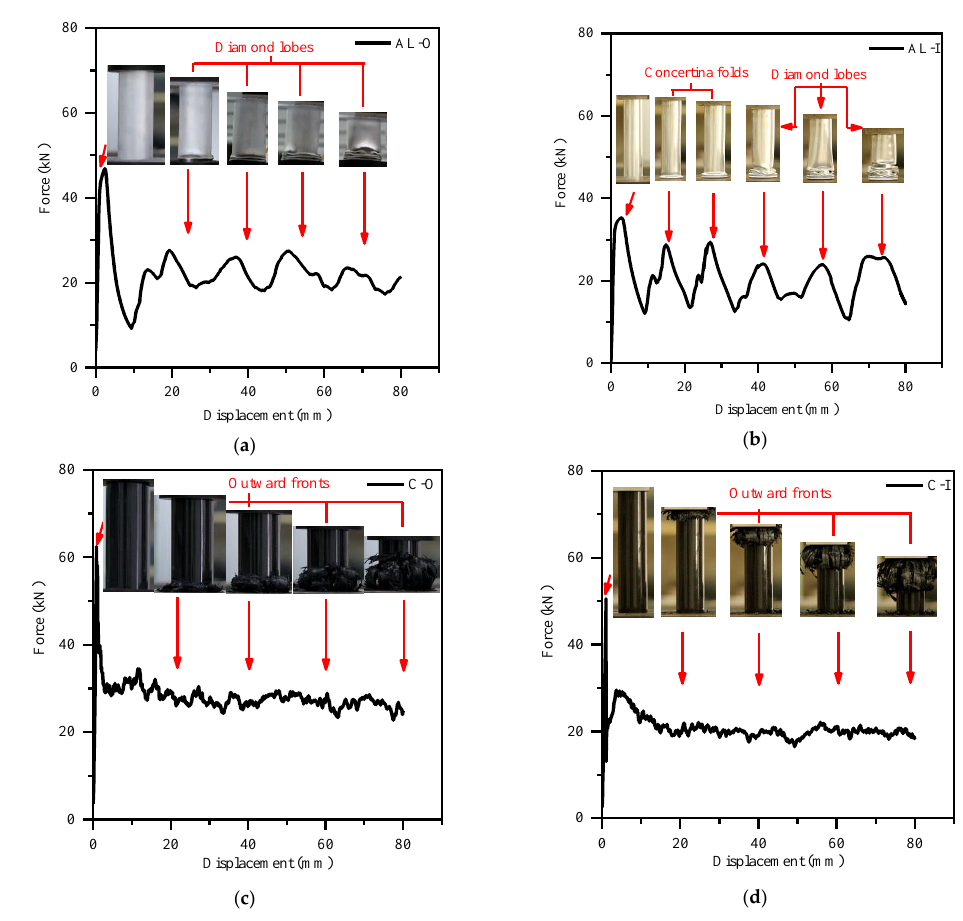
Figure 5. Deformation mode and force – displacement curves of single tubes: ( a ) AL-O; ( b ) AL-I; ( c ) C-O; ( d ) C-I. For Al-O, the diameter of the tube increased from 35 mm to 60 mm compared with al-I; it exhibited a concertina mode only at the beginning of compression, and then it turned into diamond mode; however, the stability of the compression process seemed worse, the force was irregular and unrepeatable, and it changed within a small